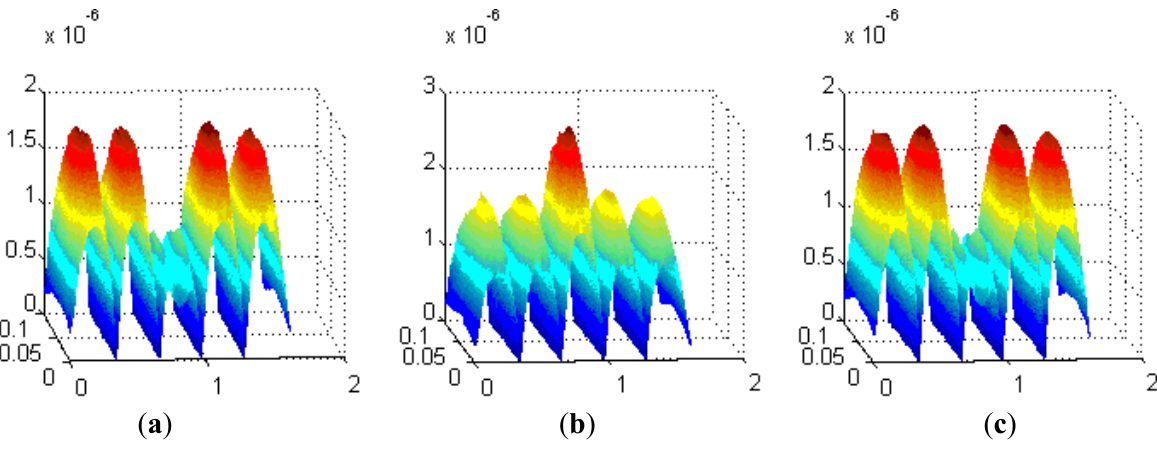
Figure 21. The spatial magnetic field affected by different